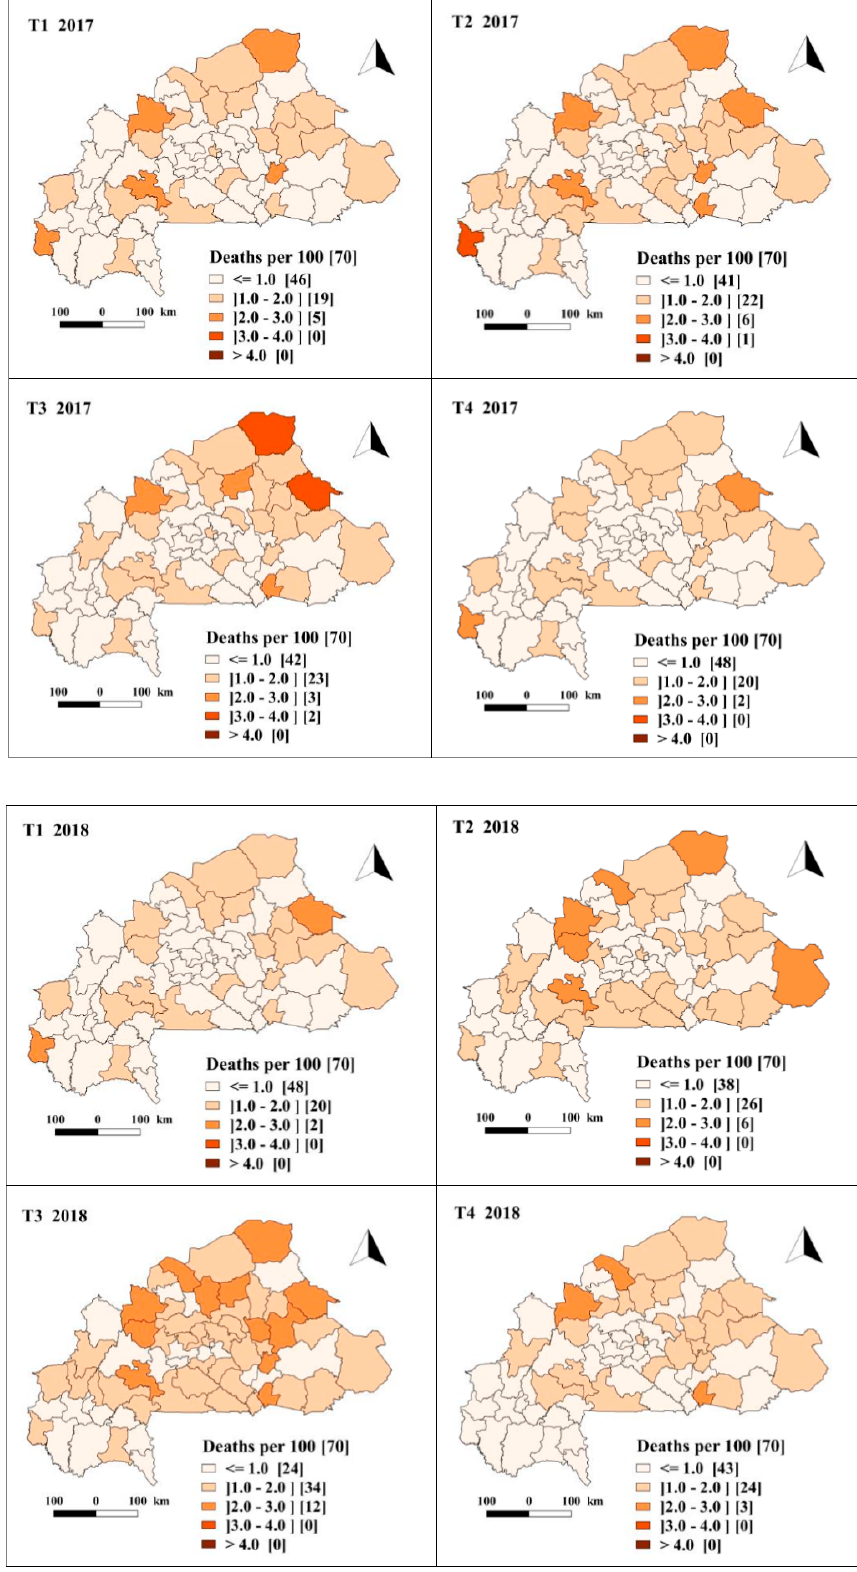
Figure 2. Spatiotemporal trends in the predicted malaria case fatality rate per 100 severe malaria cases in children under five, estimated from the Bayesian spatiotemporal model (January 2013–December 2018). T1, T2, T3 and T4 represent the first, second, third and fourth trimester (quarter) of each year